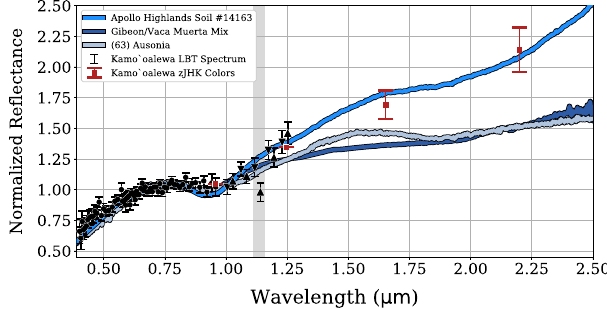
Fig. 2 Kamo ʻ oalewa ’ s Re fl ectance Spectrum. Comparison of VNIR re fl ectance spectrum of Kamo ʻ oalewa with that of a virtual mixture of the meteorites Gibeon and Vaca Muerta and the re fl ectance spectrum of lunar highlands sample #14163 (grain size 20 – 45 µ m) returned from the Apollo 14 mission 59 . Black circles indicate the spectrum collected using the MODS instrument in 2017 (0.4 – 0.95 µ m), and black triangles indicate the infrared spectrum collected using the LUCI instrument in 2019 (0.95 – 1.25 µ m). Our data shows a spectrum differing strongly from reddened silicate-rich asteroid spectra, exempli fi ed by the Sw-type (63) Ausonia 21,22 . The steeply red-sloped spectrum we observe is consistent with a highly space- weathered silicate surface, similar to that of lunar samples. The gray shaded region indicates wavelengths with time-variable telluric features that can introduce artifacts in the data. Spectra were normalized to unity at 0.7 µ m. The error bars shown for the spectrum are the photometric uncertainties at the spectral resolution as shown. The error bars for the zJHK colors represent the errors in the color ratio measurements (independent measurements were made of z/H, J/H,